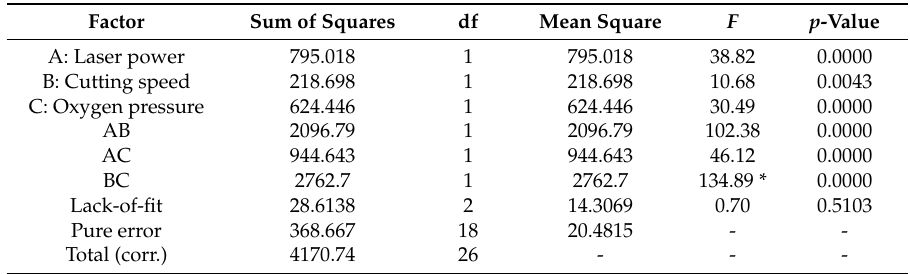
Table 4. Analysis of variance (ANOVA) table for perpendicularity tolerance. Asterisk (*) points out the factor with the strongest influence on perpendicularity tolerance.